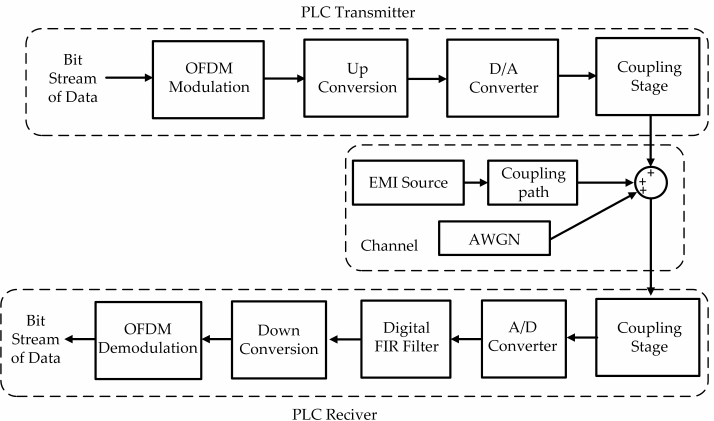
Figure 2. The PHY layer of the G3-PLC